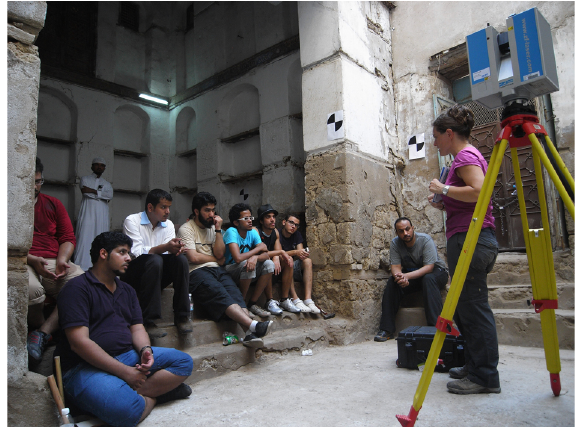
Figure 2, Introducing the Z+F Imager